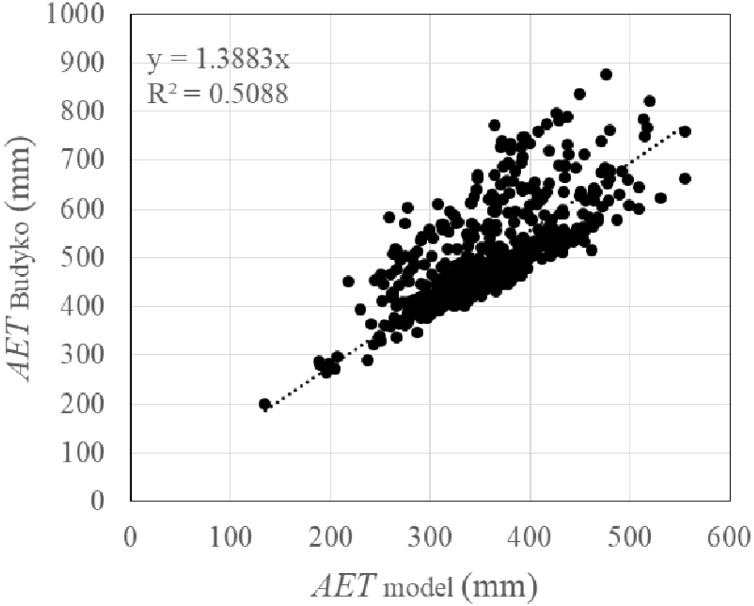
AET estimated by Budyko is 39 % higher than the calculated (and more accurate) AET.